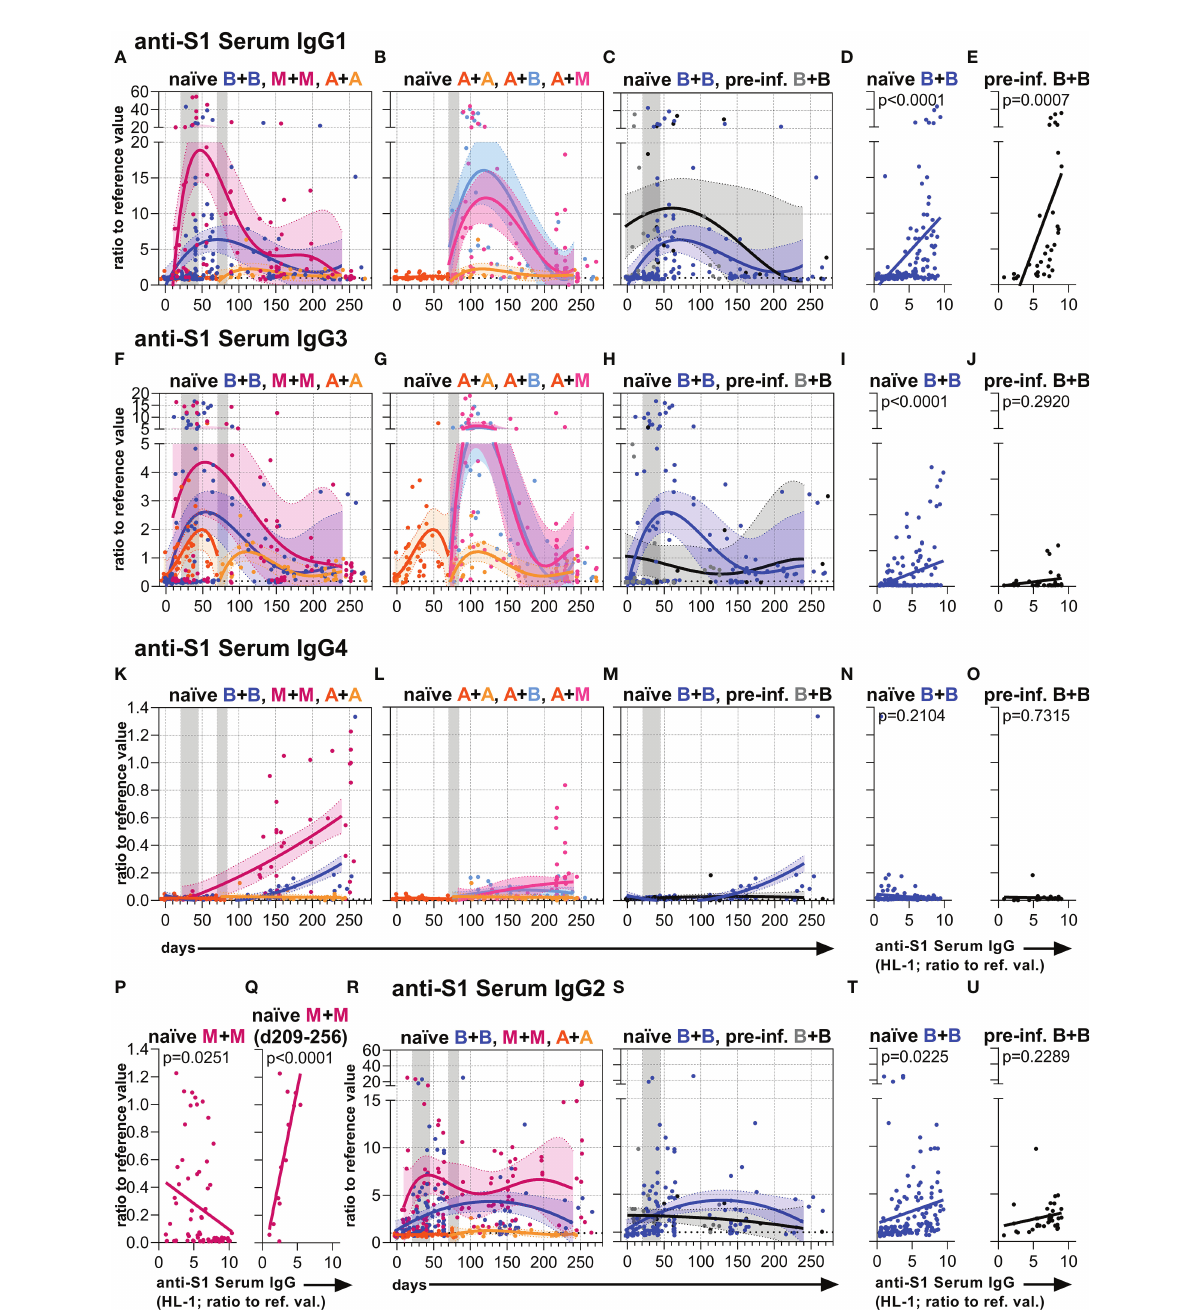
FIGURE 2 Anti-S1 serum IgG1-4 subclass levels. Anti-S1 serum (A – C) IgG1, (F – H) IgG3, (K – M) IgG4, and (R, S) IgG2 levels (ratios to reference values) of the indicated six vaccination groups. The A+B and A+M groups were not analyzed for IgG2. The used color codes are identical to Figure 1D. Gray bars: time windows of the second shot after the fi rst shot with an mRNA (between day 21 and 45) or adenovirus-based (between day 70 and 84) vaccine. Dotted lines indicate the corresponding average anti-S1 IgG1, IgG3, IgG4, or IgG2 levels of non-vaccinated healthy (negative) controls. (D, E, I, J, N – Q, T, U) Pearson correlations between anti-S1 serum IgG levels (HL-1) and anti-S1 serum (D, E) IgG1, (I, J) IgG3, (N – Q) IgG4, or (T, U) IgG2 levels (y-axis as in ( A, F, K or R , respectively)) of all paired samples from one and two-times BNT162b2-vaccinated (D, I, N, T) naïve and (E, J, O, U) pre- infected individuals, and (P, Q) two-times mRNA-1273-vaccinated naïve individuals. The IgG to IgG4 correlation in (Q) was only done with paired long-term samples of two times mRNA-1273-vaccinated naïve individuals collected between day (d) 209 and 256 upon the fi rst immunization. p - values of the indicated correlations are